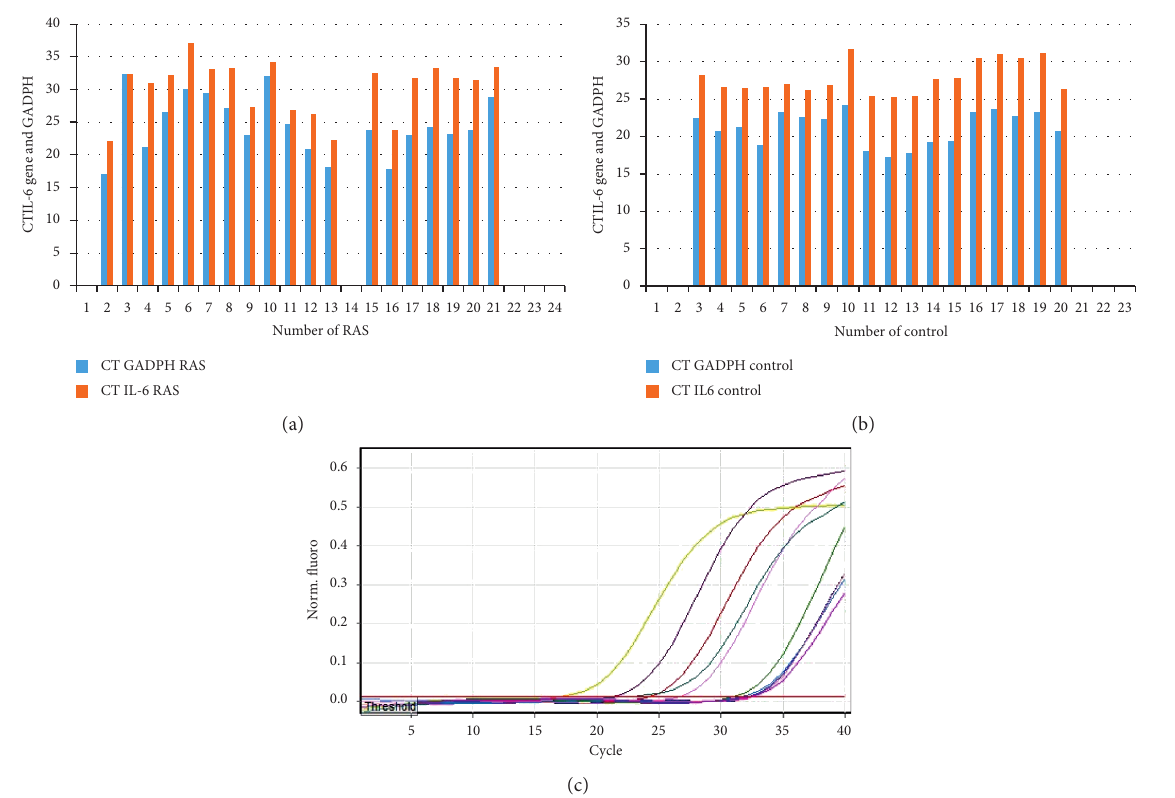
Figure 2: (a) The cycle threshold ( C T ) of the IL6 gene in the RAS group. (b) The C T of the IL6 gene in the control group (c) Quantitation data for Cycling A.Green. The result and data from RT PCR are presented as cycle threshold ( C T ), and (Figures 1–3) the C T is the cycle in which the fluorescence level reaches a specified amount (the threshold). This method (2 − ΔΔ C T formula) [41] immediately uses the C T information, and the end result is normalized as a change in the expression of the target gene (IL6) in the target sample (RAS) compared to a shown reference sample (control) to a reference gene